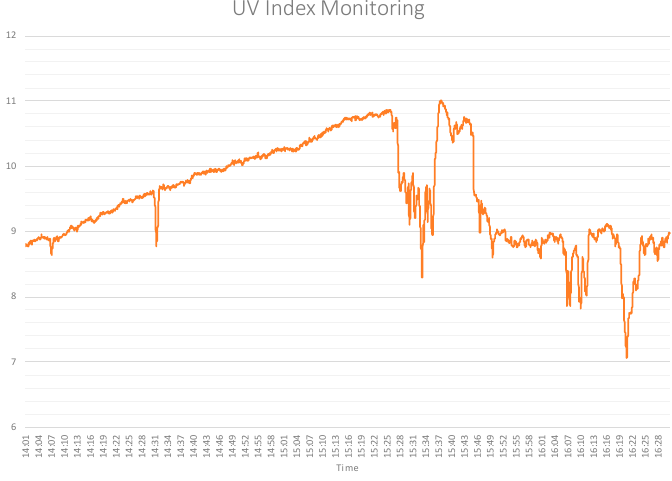
Figure 8. Evolution of the ultraviolet (UV) index.